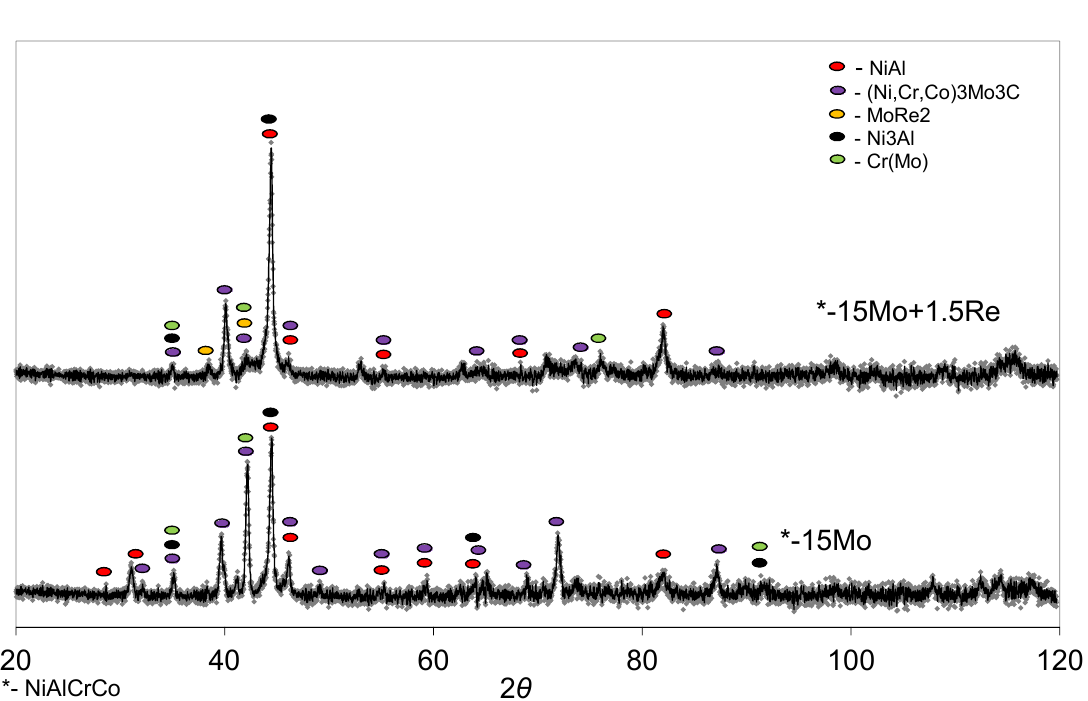
Figure 10. The XRD pattern of the NiAl–Cr–Co–( X ) alloys, X = 15%Mo and 15%Mo + 1.5%Re. The results of microstructural studies of the alloys with increased Mo and Mo + Re contents are shown in Figures 11 and 12, respectively. Table 8. The phase composition of the NiAl–Cr–Co–( X ) alloys.